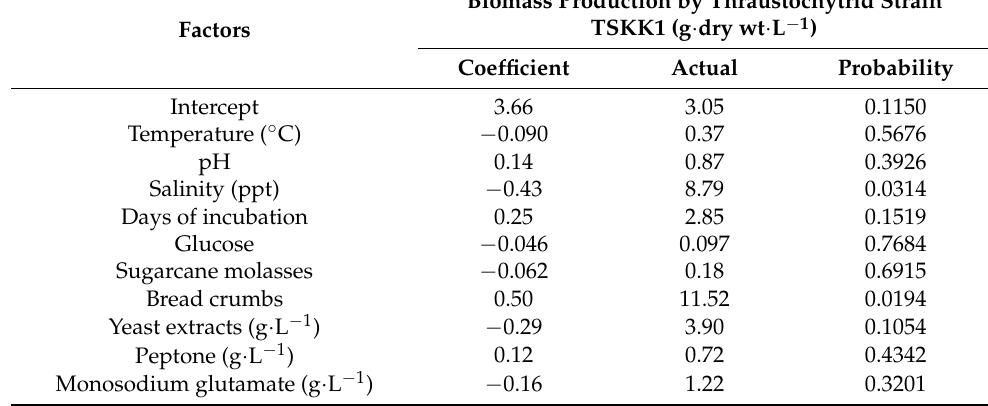
Table 2. Selection of the important biomass production influencing factors for the strains of Thraus- tochytrium kinnei (SE Coefficient =